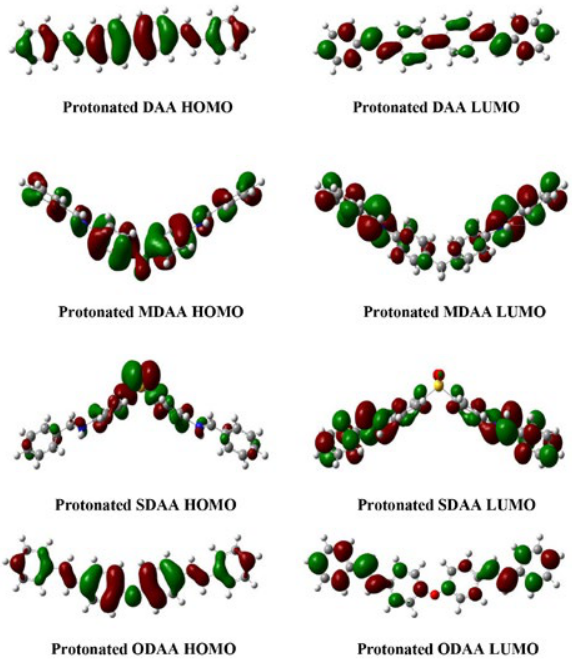
Figure 5: HOMO and LUMO orbitals of the protonated inhibitor molecules at B3LYP/6-31G